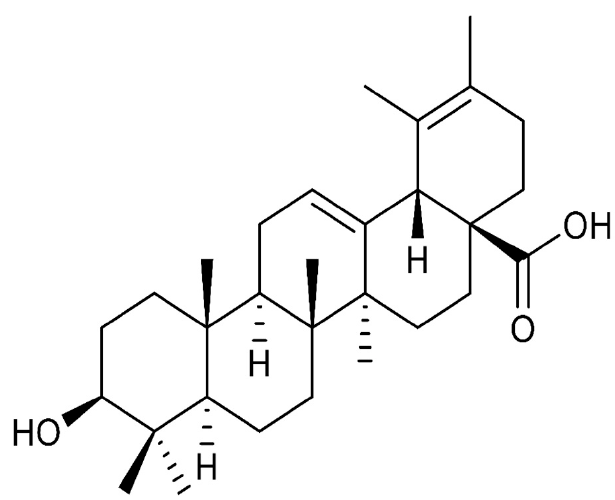
Figure 6. Chemical structure of SGB.